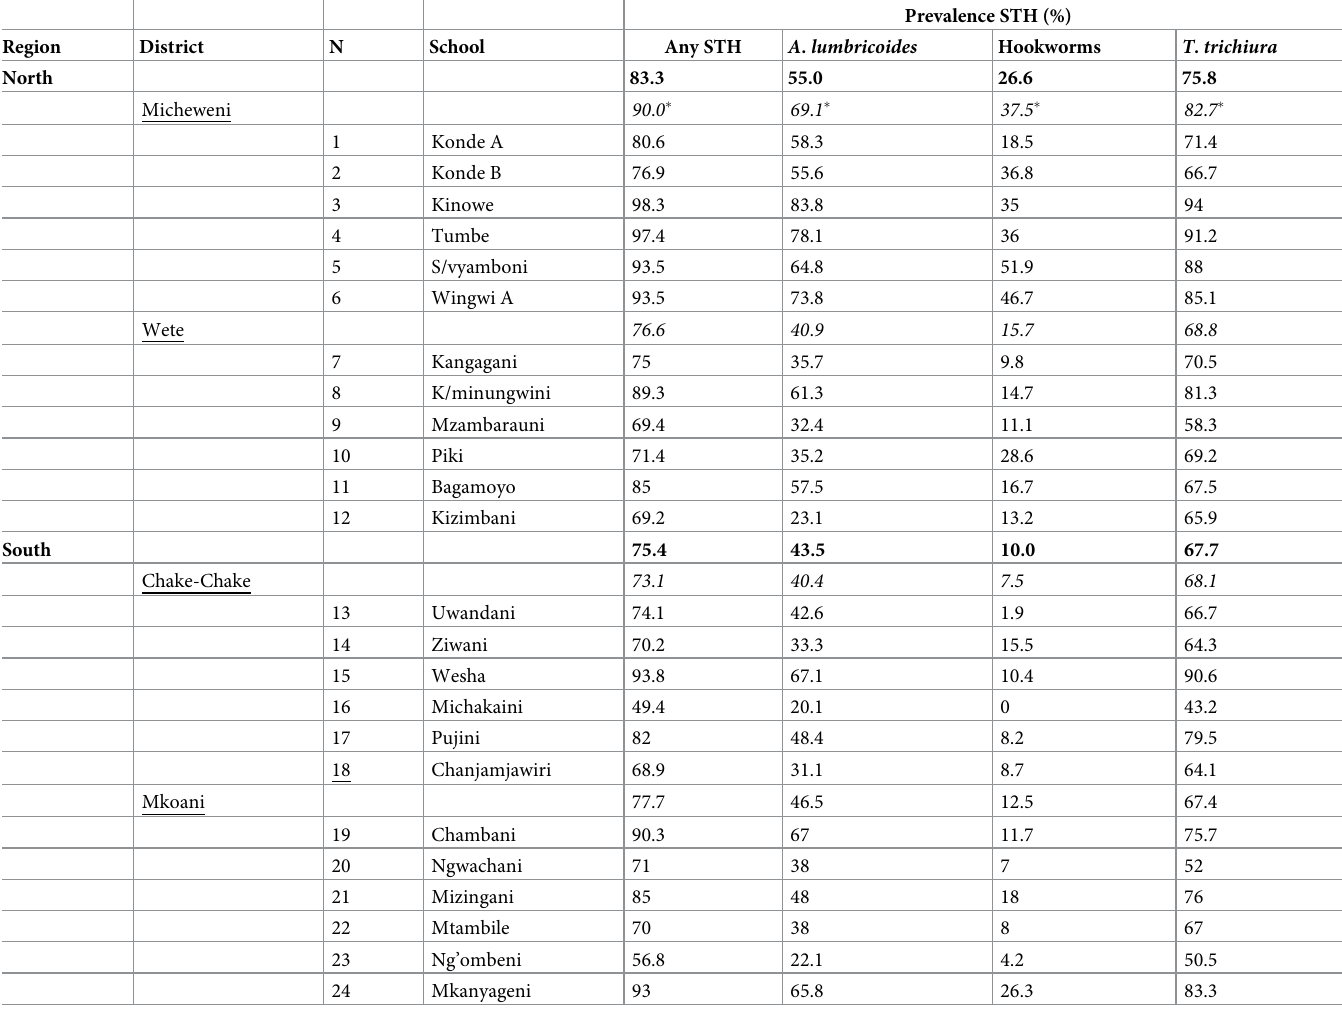
Table 2. Prevalence of STH infection across schools and districts in Pemba.